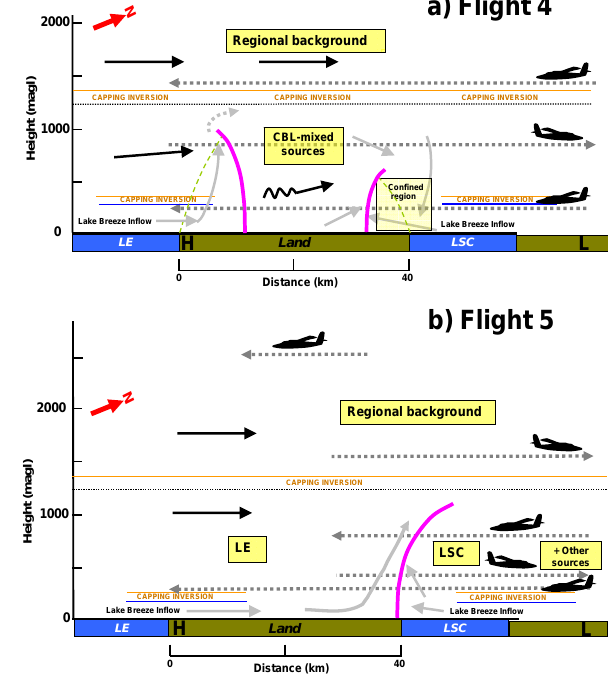
Fig. 10. Conceptual models of the flow in the vicinity of a lake-breeze circulation for (a) Flight 4 and (b) Flight 5 based on the interpretation of aircraft, model and trajectory data. Black straight arrows=synoptic flow, black, squiggly arrow=convective boundary layer motion, dashed, dark grey horizontal arrows=flight path/direction, dashed, solid grey arrows=lake-breeze motion, light grey arrow=slower flow due to effects from LE return flow, H=Harrow,